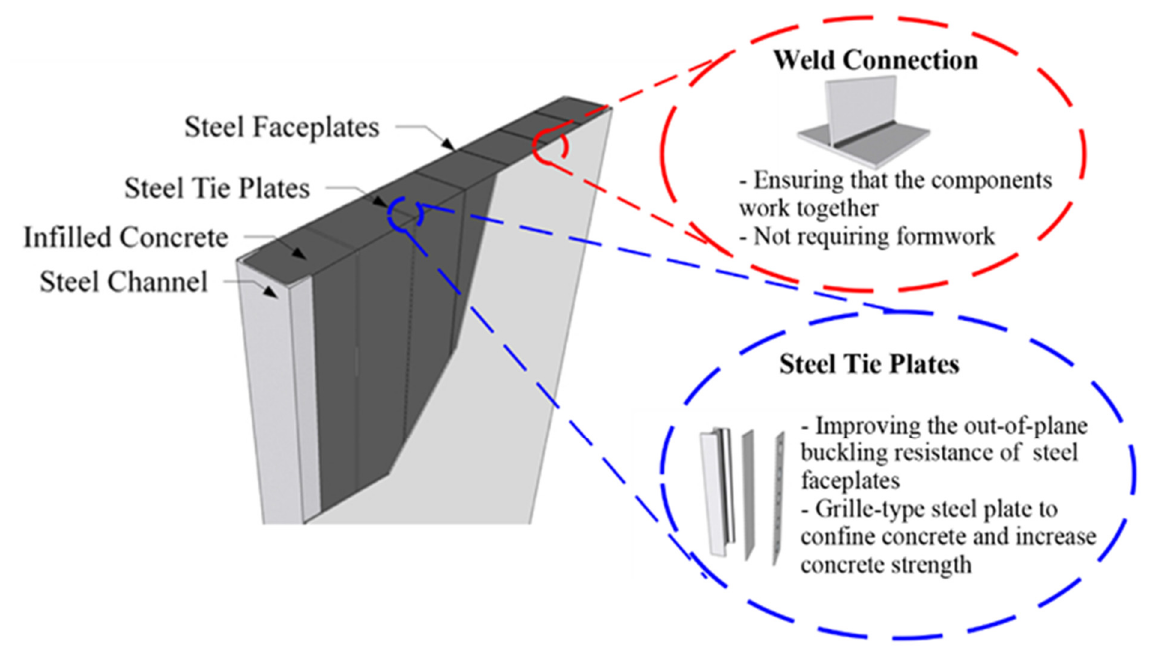
Figure 1. Schematic of grille-type steel plate concrete composite shear walls (GSPCWs). To date, only limited research has been performed regarding GSPCW wall systems.